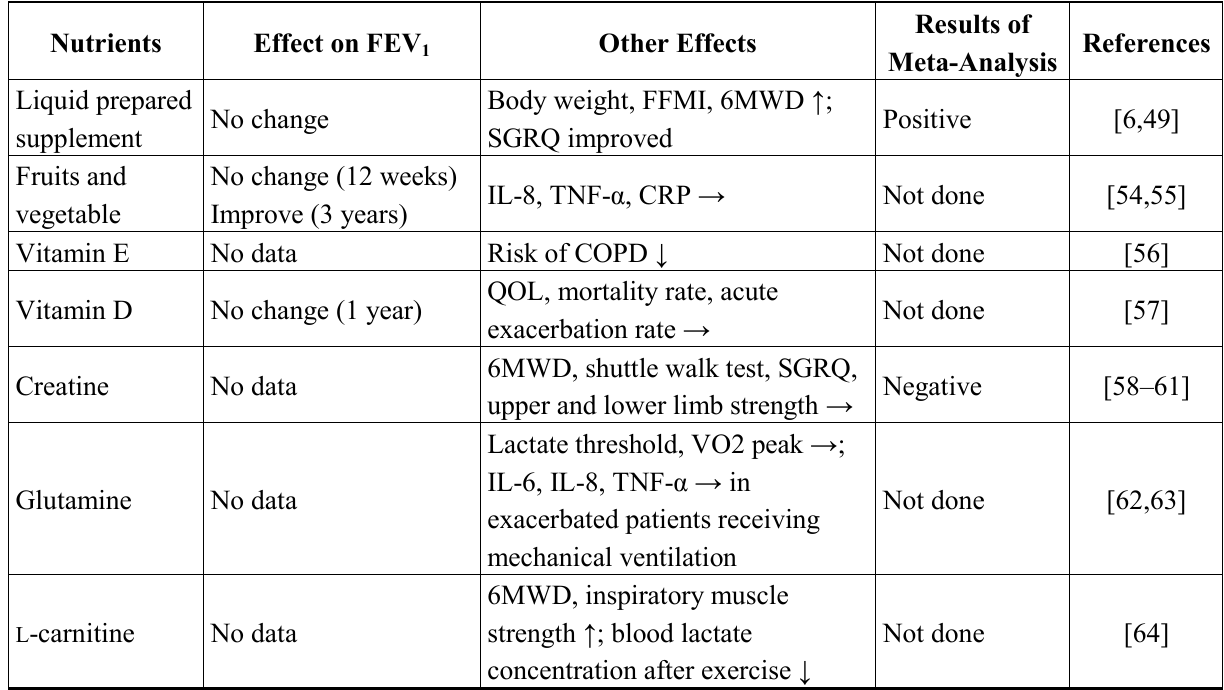
Table 2. Results of randomized controlled trials (RCTs) of nutritional supplement therapy for